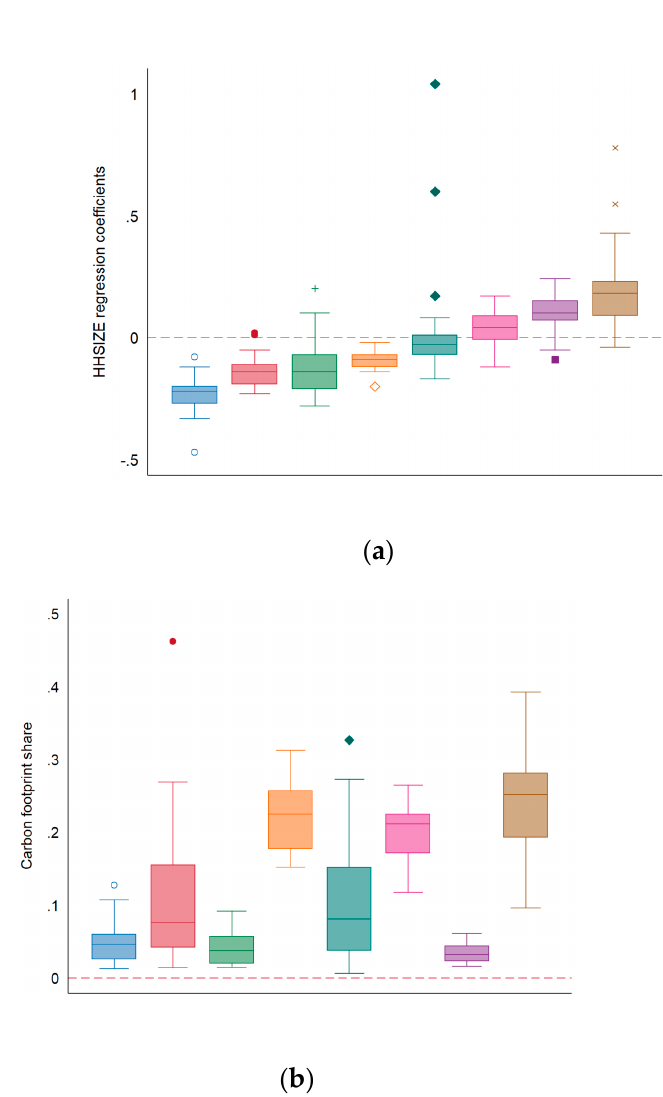
Figure 6. A summary of the HHSIZE regression coefficients of EU countries (displayed on Figure 7) with the logarithm of the per capita carbon footprint by consumption category as dependent variables ( a ) and the proportion of the individual consumption categories of the overall carbon footprint of EU countries ( b ). The categories are ordered by the median HHSIZE effect depicting the importance of the household economies of scale from the strongest to the weakest.